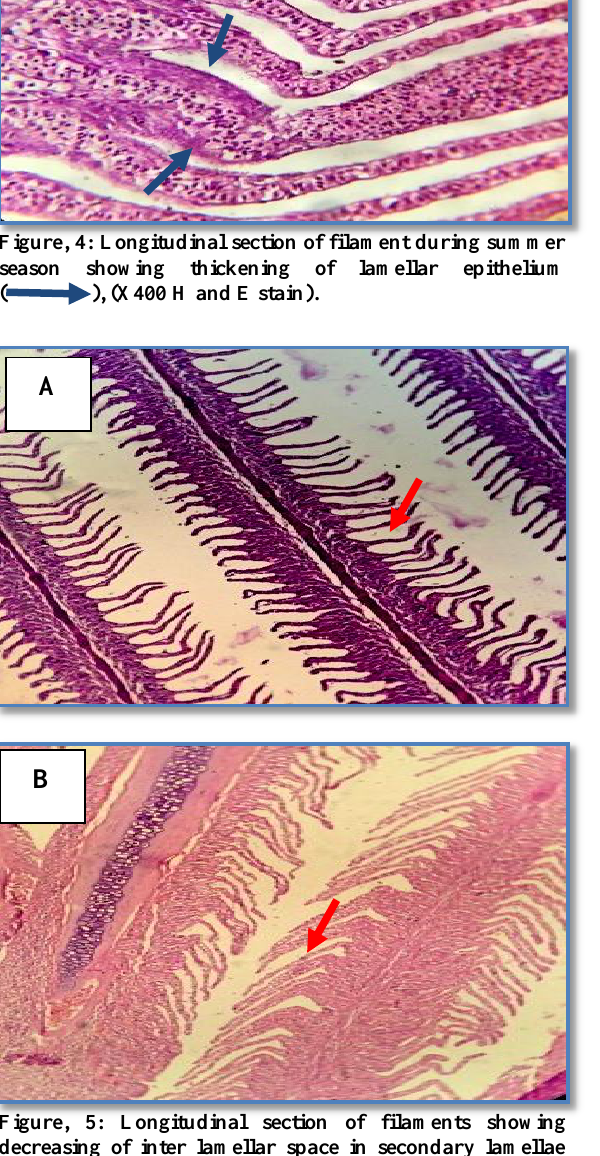
Figure, 5: Longitudinal section of filaments showing decreasing of inter lamellar space in secondary lamellae ( ) A Summer season, B Winter season (X100 H and E stain).